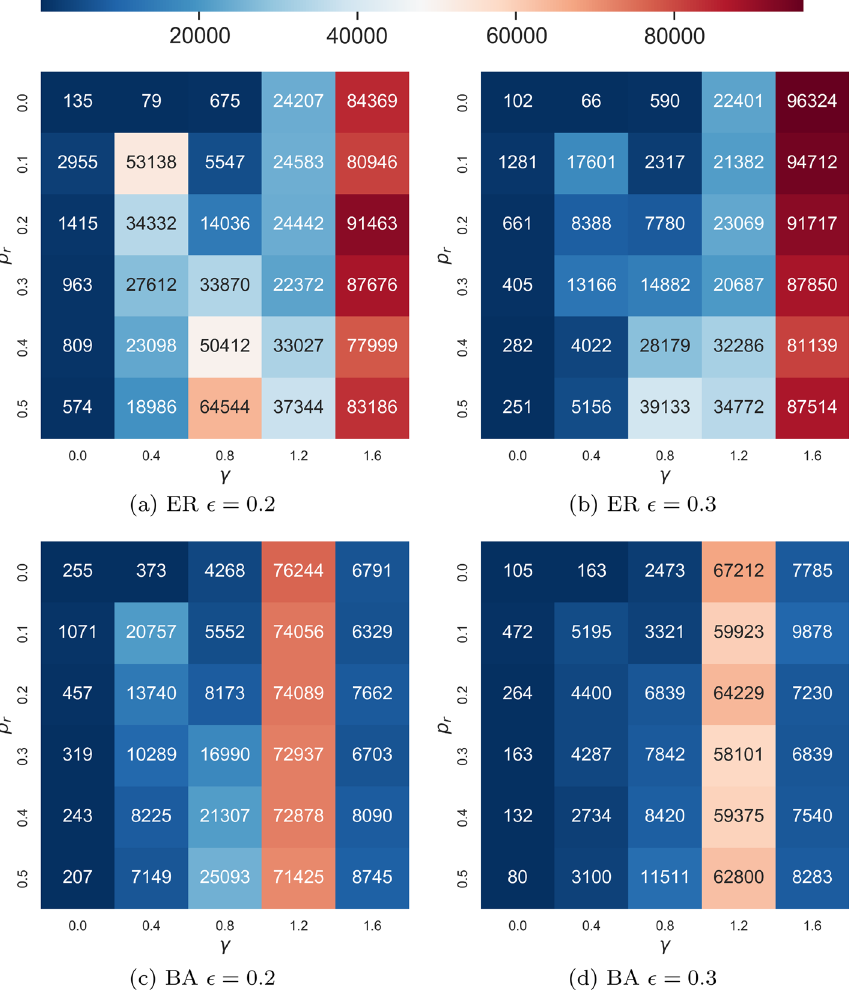
Fig. 4 Average number of iterations to convergence in the Adaptive Algorithmic Bias model. Average number of iterations to convergence in the Adaptive Algorithmic Bias model as a function of γ and p r for a ǫ = 0.2 , b ǫ = 0.3 and c , d in a scale-free Barabási–Albert graph. These values are averaged over 30